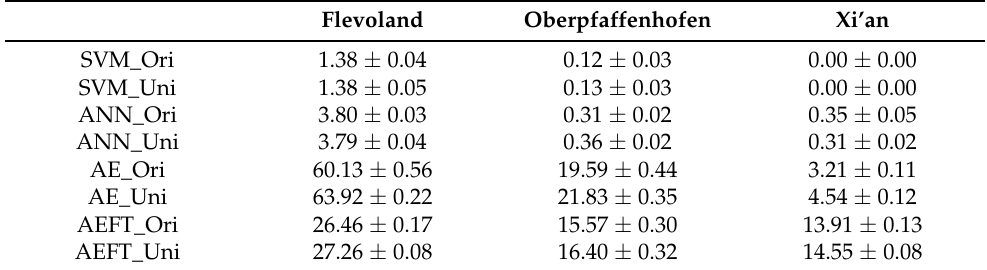
Table 17. Training time of four classifiers for parameter normalization on three PolSAR datasets.